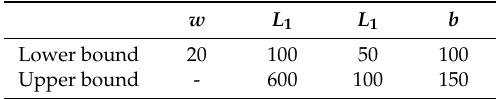
Table 1. Variation range for the design variables (units in µ